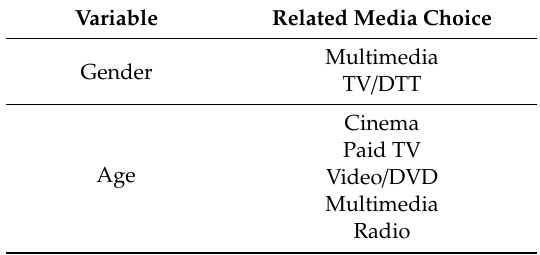
Table 9. Sociodemographic variables that influence audiovisual media consumption.